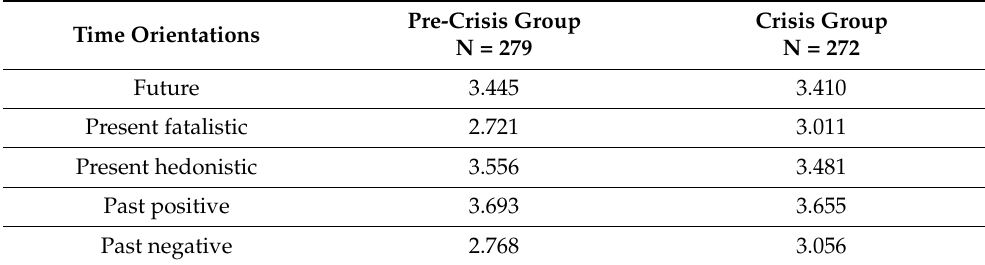
Table A2. Mean values for time orientations in the pre-crisis and crisis groups in the south-eastern